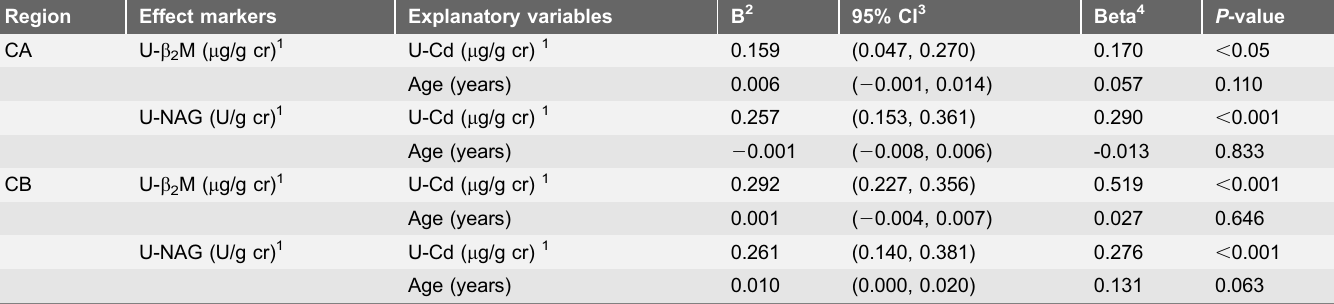
Table 3. Results of the multiple linear regression analysis on individual factors related to Cd-induced renal tubular damage. Region